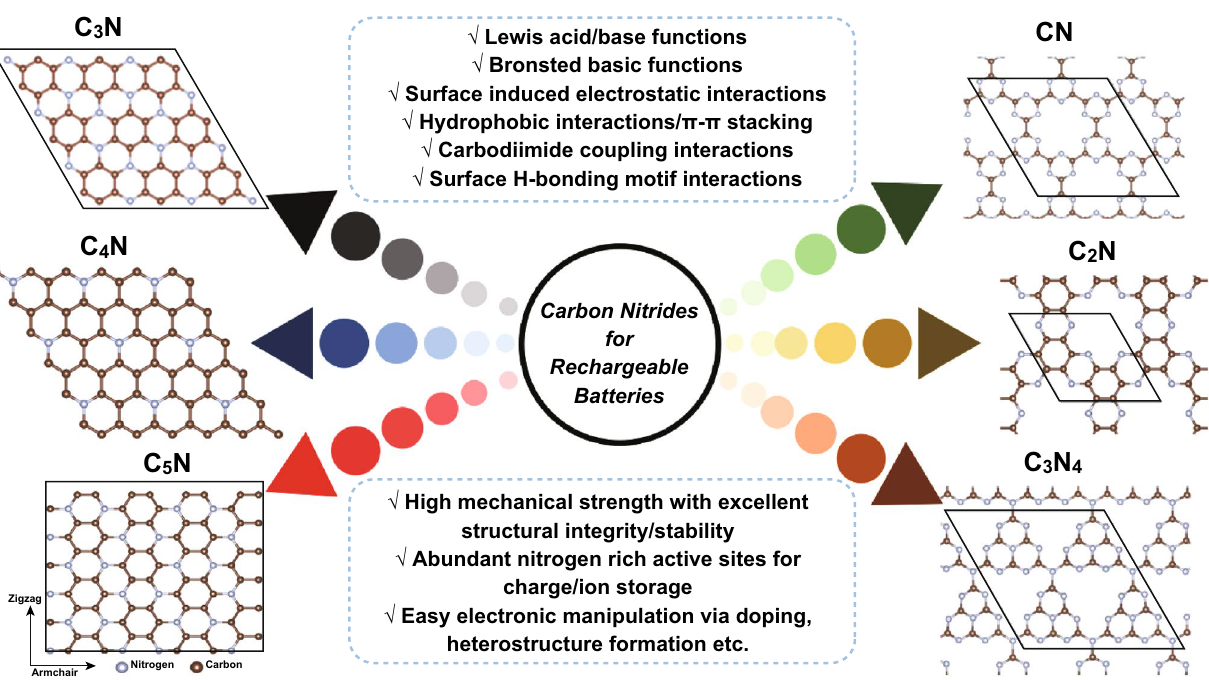
Fig. 3 Geometric structures of the pyridinic and graphitic-N-based carbon nitrides reported for rechargeable batteries and their surface function- alities. The brown spheres represent carbon atoms, and the light blue one represents nitrogen atoms in the 2D carbon nitrides structures. (Color figure